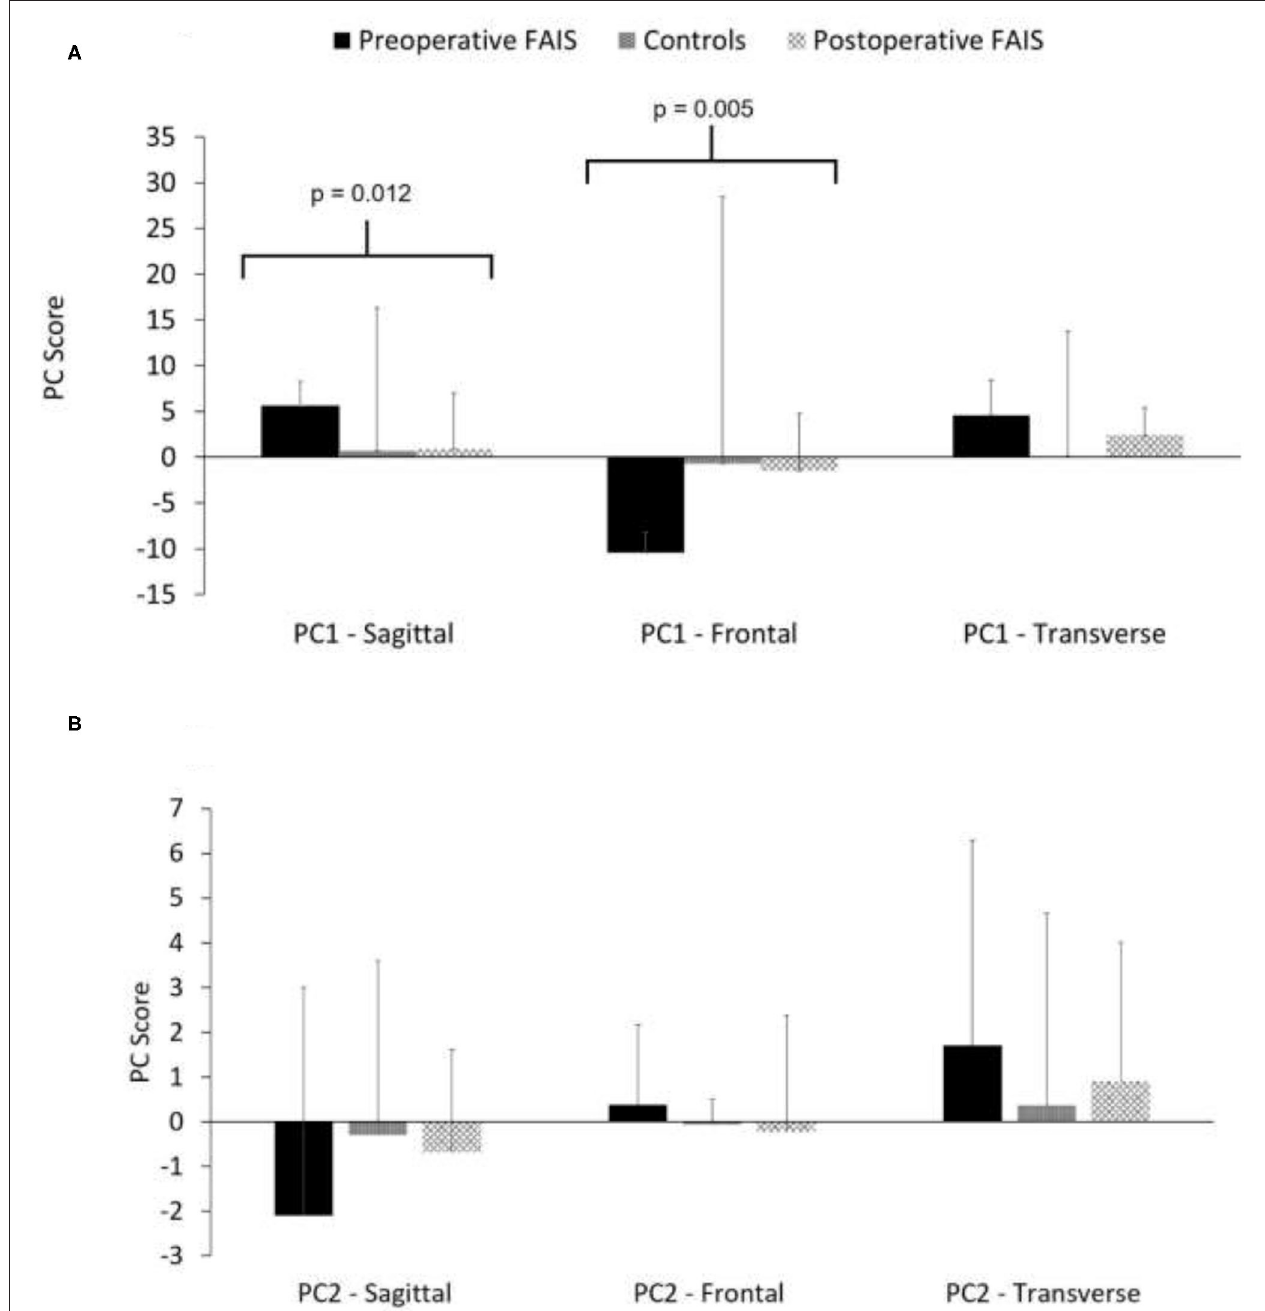
FIGURE 2 | Plane specific contributions for PC1 (A) and PC 2 (B) to the hip joint kinematic covariation pattern for each group.